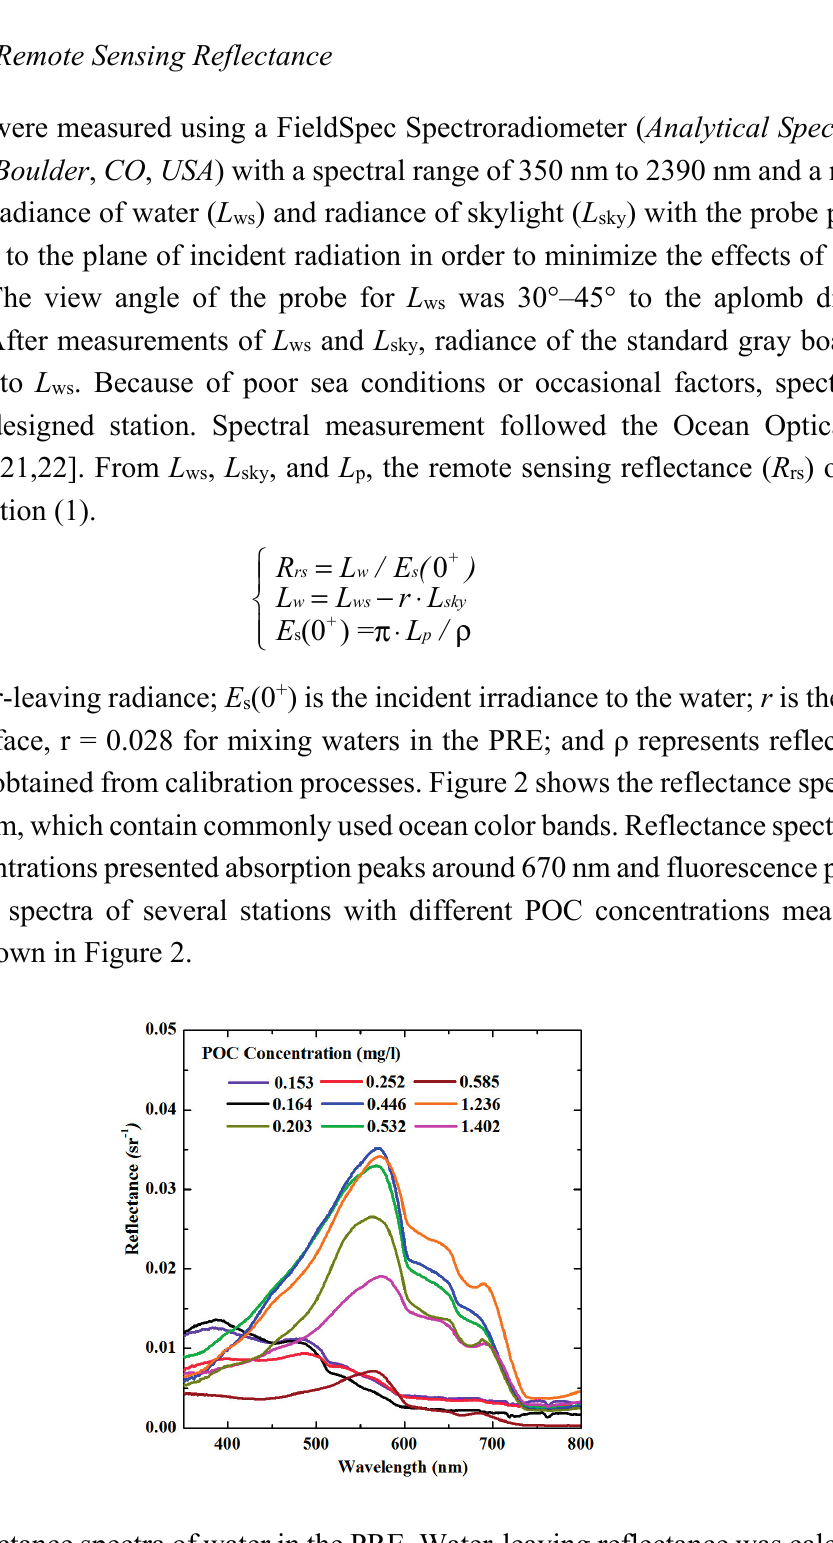
Figure 2. Reflectance spectra of water in the PRE. Water-leaving reflectance was calculated using Equation (1). Both water-leaving reflectance and POC concentration differed with